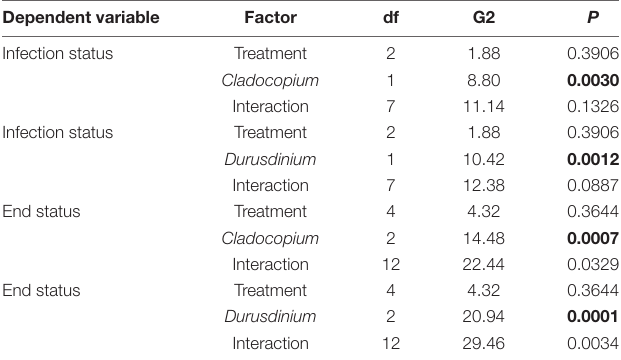
TABLE 1 | Three way log-linear contingency table analysis of treatment (control, limited, unlimited) and species of S ymbiodiniaceae (Cladocopium or Durusdinium present) on the infection status (infected, uninfected) or end of experiment status (diseased, healed, resistant). Dependent